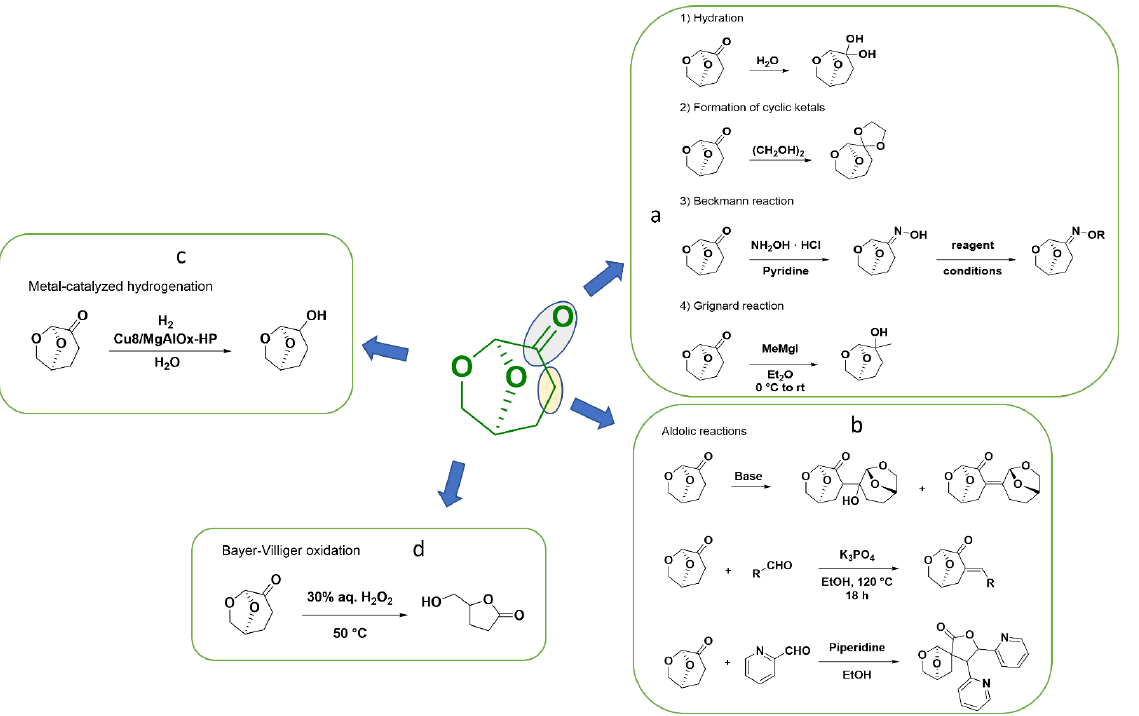
Figure 2. Reactivity of Cyrene; ( a ) reactivity of carbonyl group of Cyrene; ( b ) enol-type reactivity of Cyrene; ( c ) reduction of Cyrene; ( d ) oxidation of